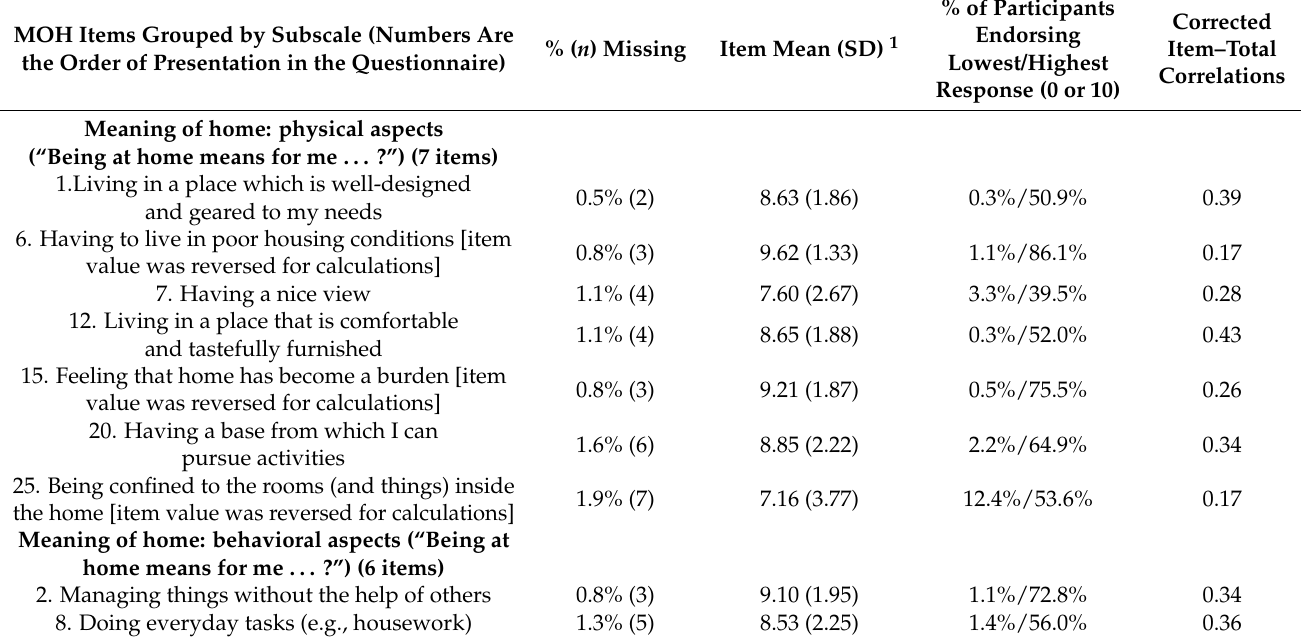
Table 2. Analysis of the items in the four subscales of the Meaning of Home (MOH) questionnaire.